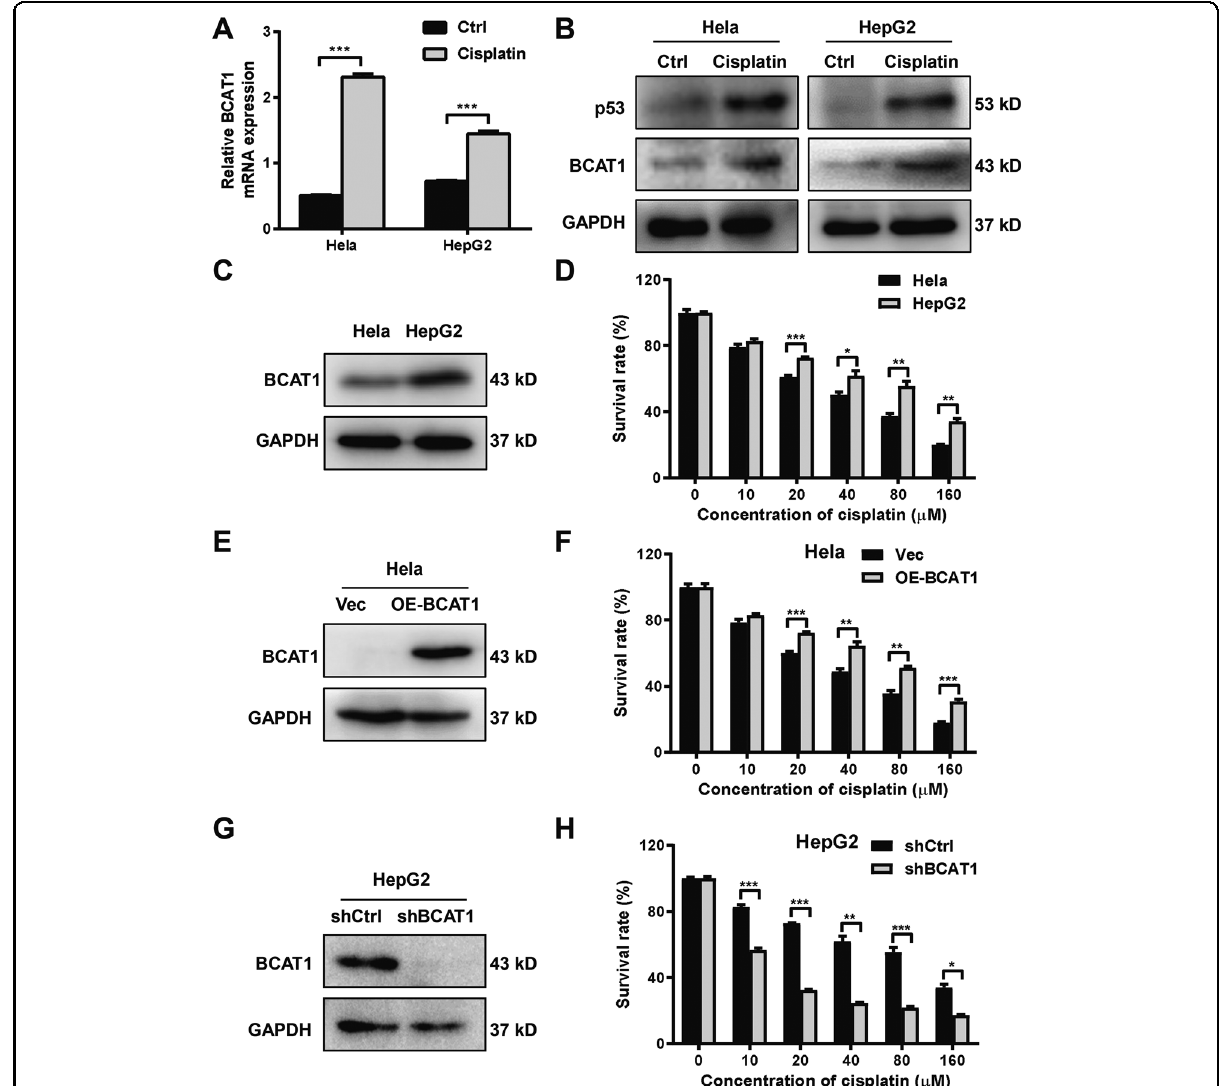
Fig. 1 BCAT1 expression decreases cisplatin sensitivity. A qRT-PCR was performed to detect BCAT1 mRNA expression in Hela and HepG2 cells treated with cisplatin. Hela cells were treated with 20 μ M cisplatin and HepG2 cells were treated with 10 μ M cisplatin for 24 h. B Western blot analysis of BCAT1 and p53 protein expression in Hela and HepG2 cells treated with cisplatin (20 and 10 μ M, respectively) for 24 h. C Western blot analysis of BCAT1 protein expression in Hela and HepG2 cell lines. D CCK-8 assays were performed to measure the survival rate of Hela and HepG2 cells treated with different concentrations of cisplatin for 24 h. E A Western blot was used to verify the increased protein level of BCAT1 in Hela cells overexpressing BCAT1. F CCK-8 assays were performed to examine the cytotoxicity in Hela cells overexpressing BCAT1 that were treated with different concentrations of cisplatin for 24 h. G A Western blot was used to verify the decreased protein level of BCAT1 in the BCAT1 knockdown HepG2 cells. H CCK-8 assays were used to examine the cytotoxicity in the BCAT1 knockdown HepG2 cells treated with different concentrations of cisplatin for 24 h. Vec, empty vector; Ctrl, control. Three independent experiments were performed. * P < 0.05, ** P < 0.01, *** P <